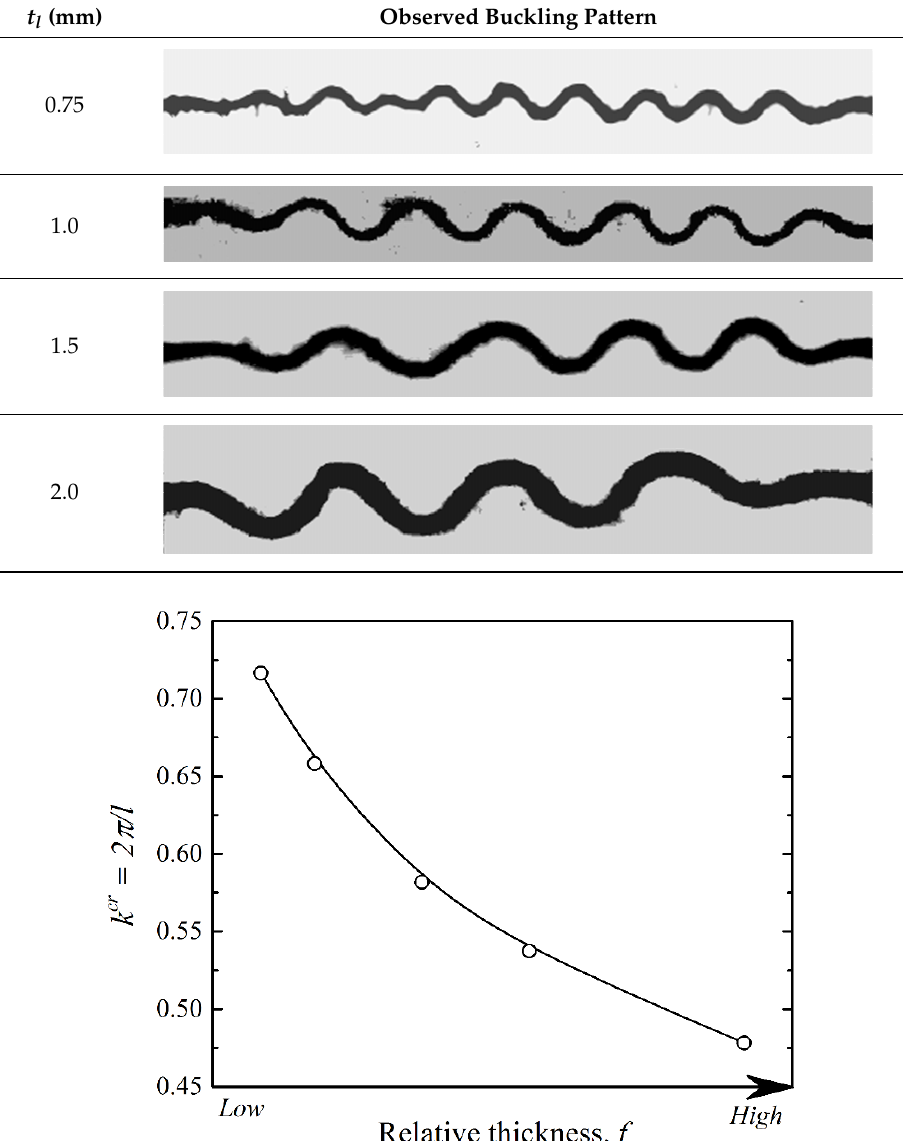
Figure A2. Dependence of critical wavenumber on relative thickness of interphasial layer.